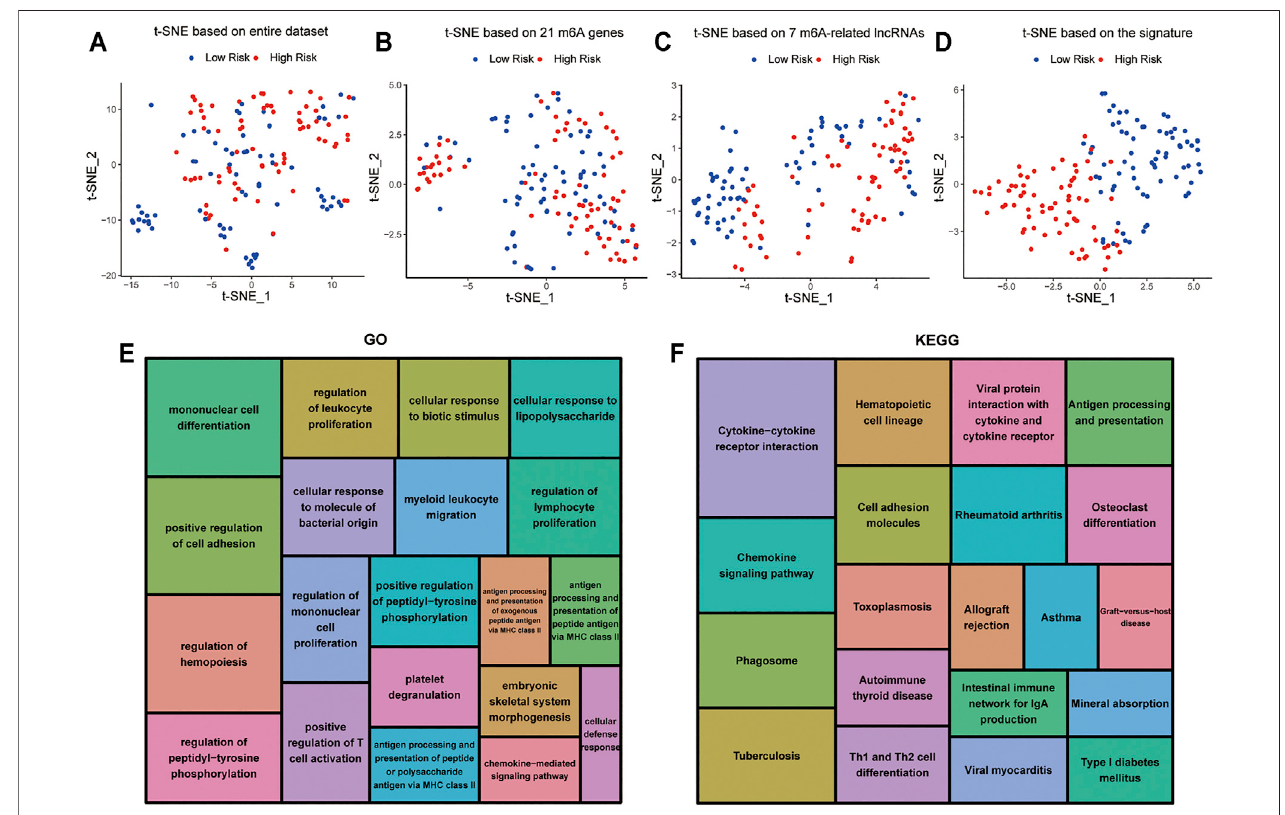
FIGURE 8 | Cellular biological effects related to the signature (A) Based on whole gene expression pro fi les. (B) Based on 21 m6A genes. (C) Based on 7 m6A- relatedlncRNAs. (D) Based on thesignature. (E) GOfunction annotation showed the top 20enriched biological processes. (F) KEGG pathway analysis showed the top 20 enriched pathways.